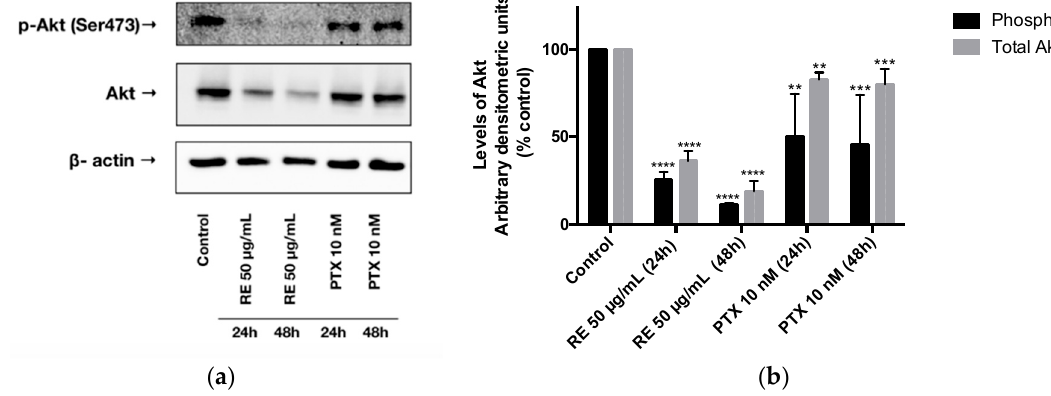
Figure 3. Effect of rosemary extract on Akt. Cell lysates were prepared from MDA-MB-231 breast cancer cells treated with either 50 µg/mL rosemary extract (RE) or 10 nM paclitaxel (PTX) for 24 or 48 h. Cell lysates (20 µg) were immunoblotted using specific antibodies against Akt, p-Akt, or β -actin. Representative immunoblots are shown ( A ). The densitometry of the bands, expressed in arbitrary densitometric units, was corrected to β -actin levels and is presented as percent of control ( B ). The data are the mean ± SEM of three independent experiments. ** p < 0.01, *** p < 0.001, **** p < 0.0001.